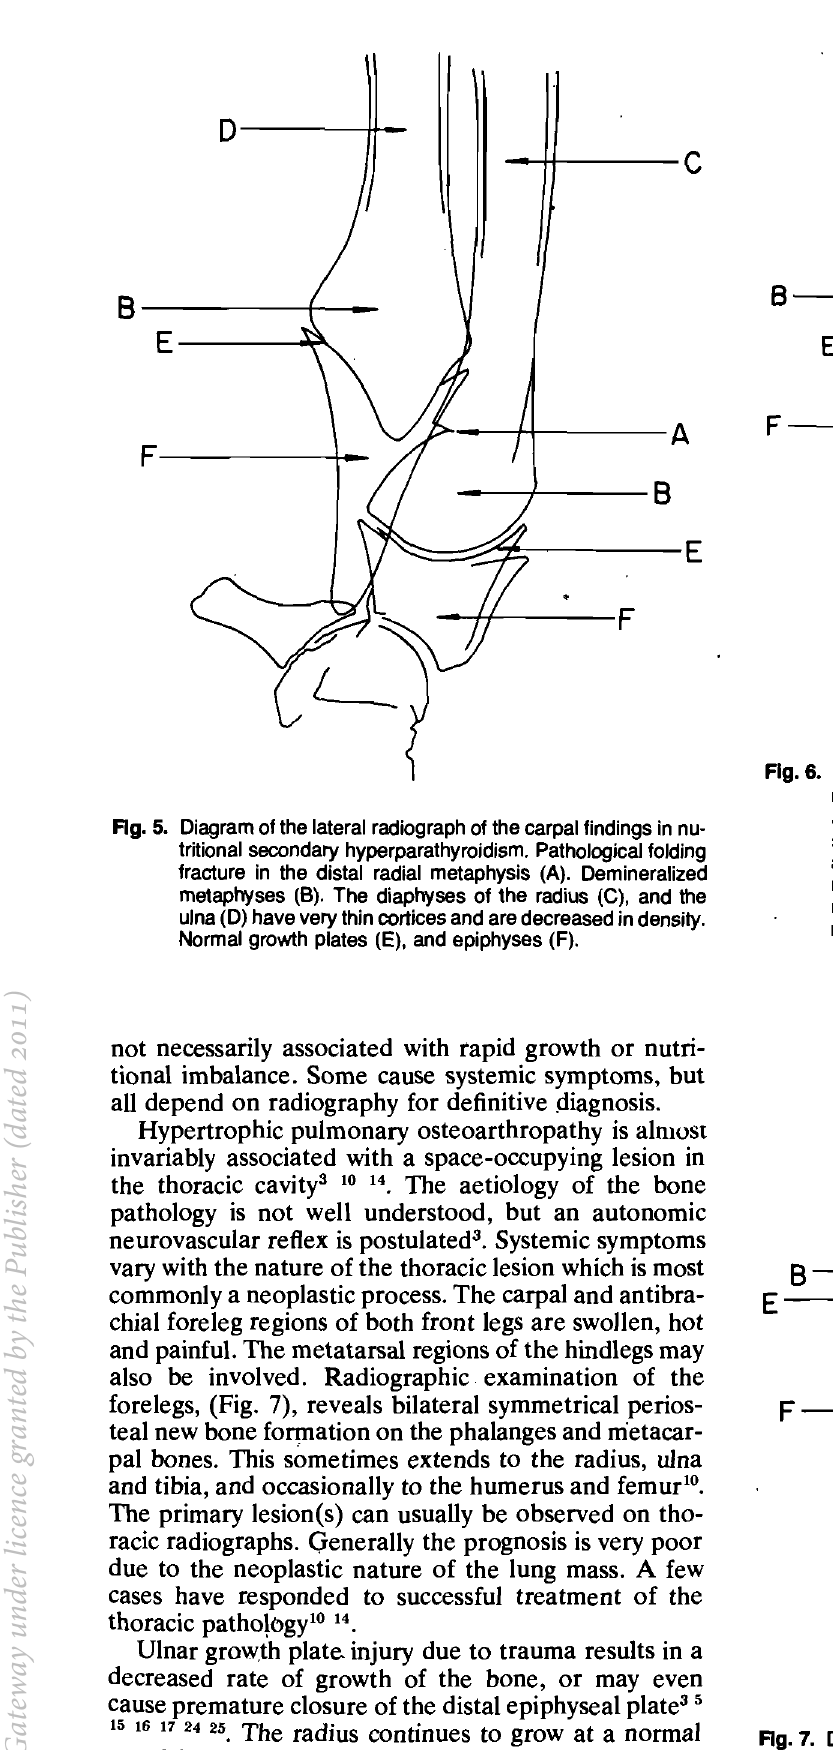
Fig. 7. Diagram of the lateral radiograph of the carpal findings in ad vanced hypertrophic pulmonary osteoarthropathy. Periosteal new bone formation occurs on the shafts of bones (A). The metaphyses appear normal (8). Radial (C) and ulnar (D) dia physes are normally mineralized but have periosteal prolifer ations along their surfaces. The growth plates (E) and epi physes (F) are